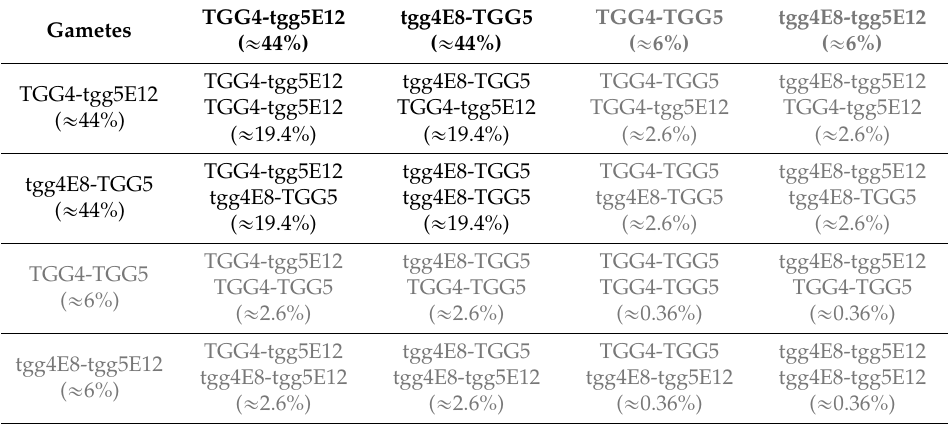
Table 1. Genotypes of gametes and F2 individuals of the hybrid TGG4tgg5E12 / tgg4E8TGG5